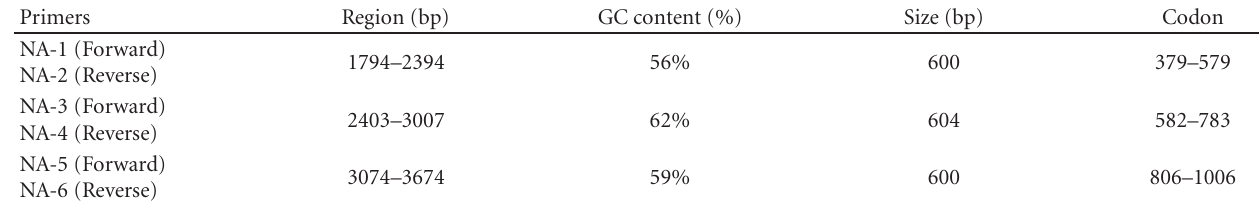
Table 1: Primer sequences for the amplification of UL54 gene.